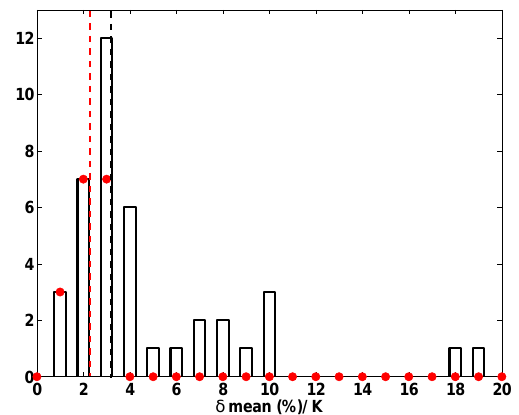
Fig. 8. Histogram of the percentage changes in mean rainfall per de- gree change in temperature for all significant scenarios of all models as in Fig. 7. Red dots represent the values for the models in the up- per panel of Fig. 7. Black dashed line shows the median value for the ensemble of all models, and red dashed line shows the median value for the most realistic models (i.e., the ones in the upper panel of Fig. 7).